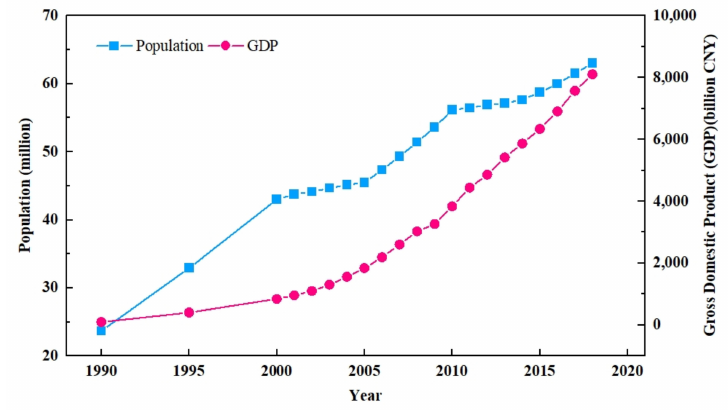
Figure 9. Number of resident population and GDP in the GBA from 1990 to